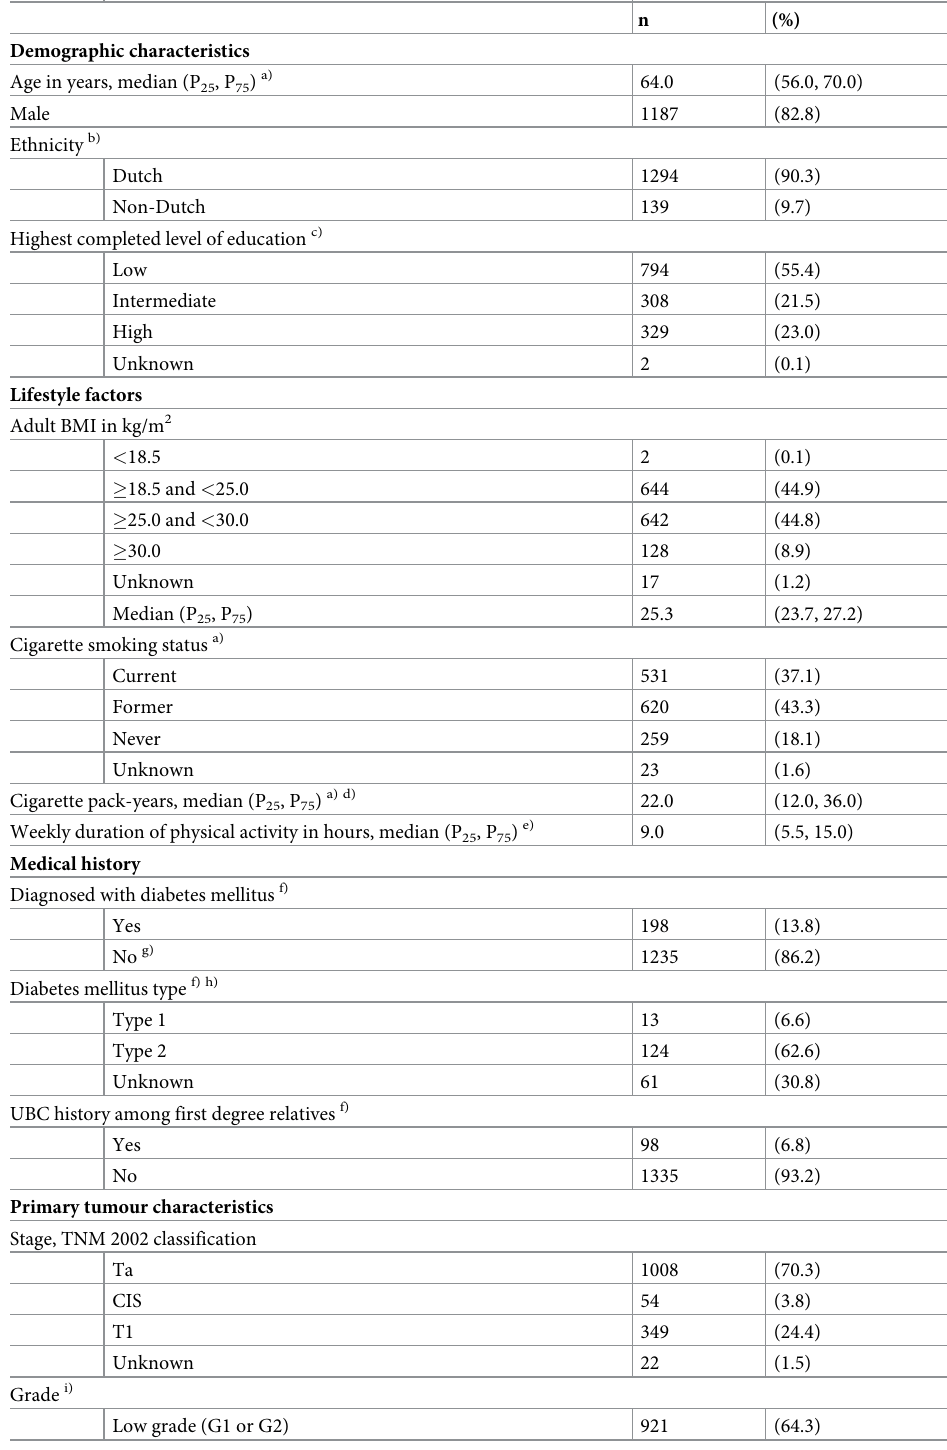
Table 1. Patient characteristics on lifestyle and medical history, and characteristics regarding their primary bladder tumour and initial